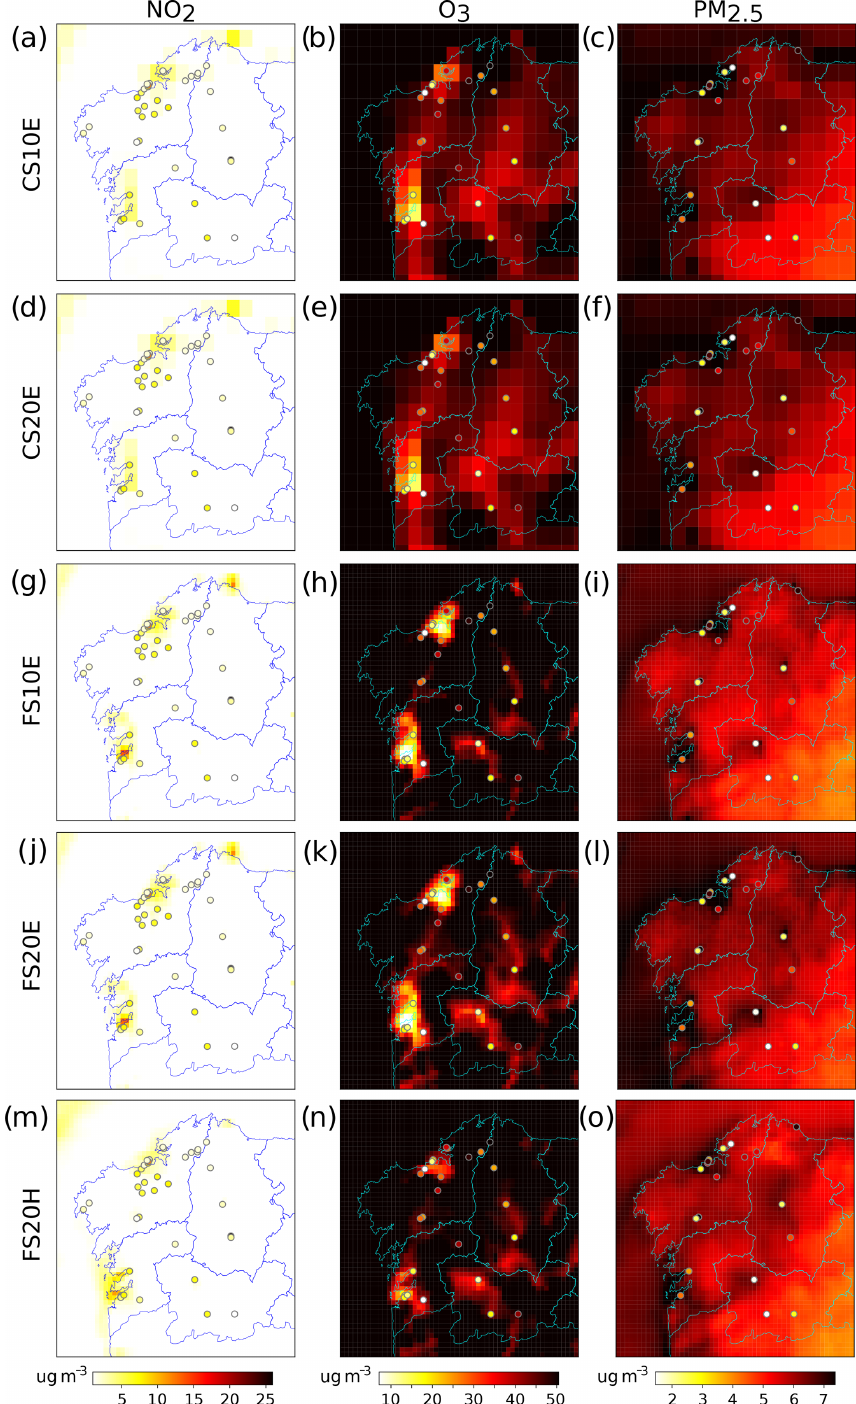
Figure 6. Observed (dots) vs. modeled (underlying pattern) temporal mean values for the daily minimum concentrations of NO 2 , O 3 and PM 2 . 5 , as well as for the five experiments marked with in asterisk in Table 3, all run with the SAPRC mechanism. The spatial verification results for each panel are provided in Table